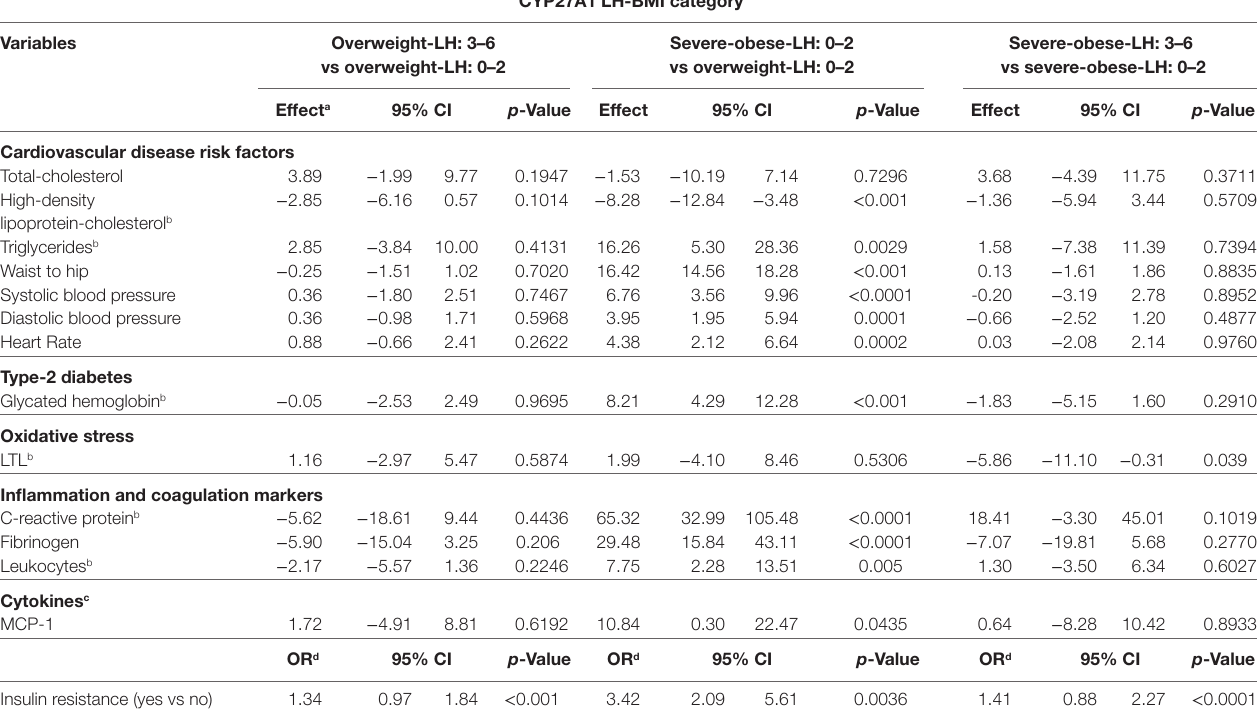
TaBle 4 | Multivariable